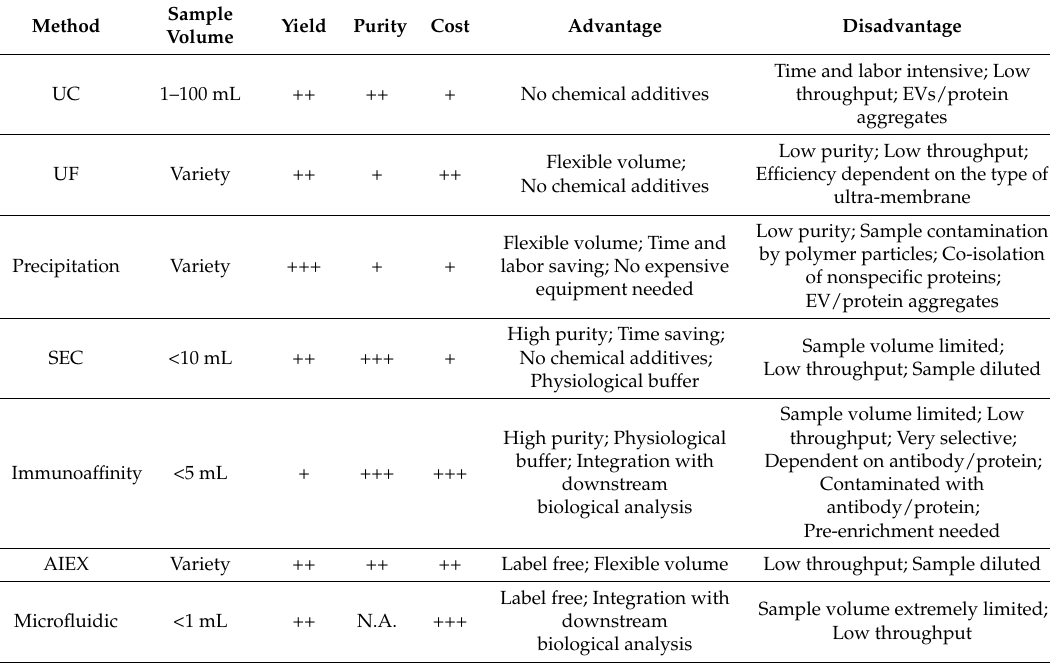
Table 2. Comparison of EV Isolation